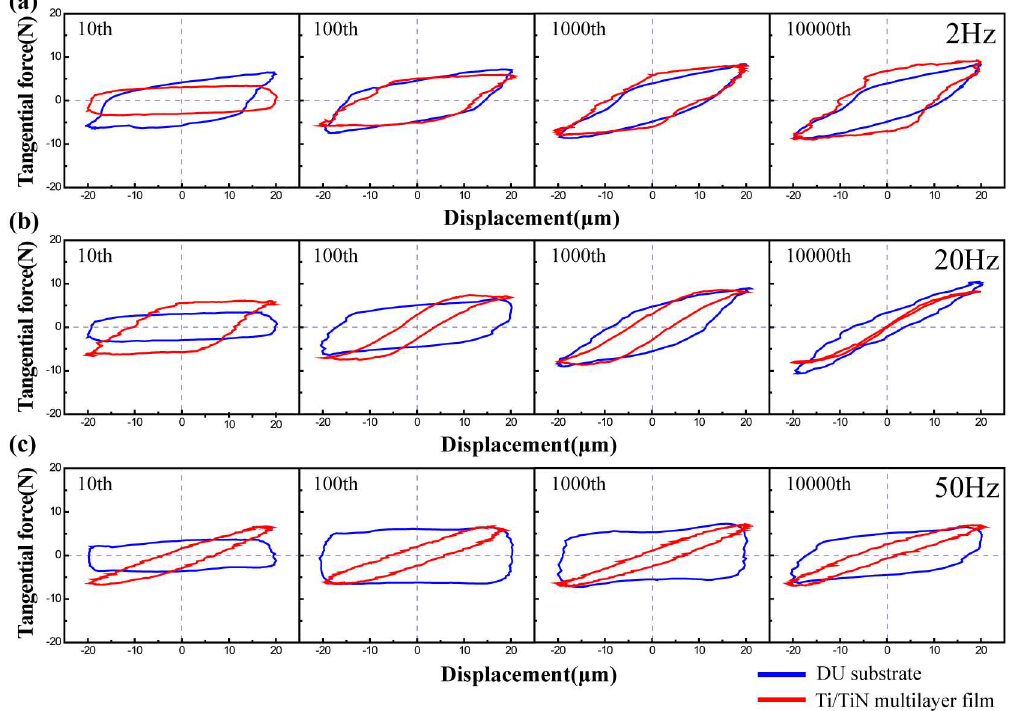
Fig 4. Variation of Ft–D curves as function of number of cycle under the frequency of 2Hz (a), 20Hz (b) and 50Hz (c).